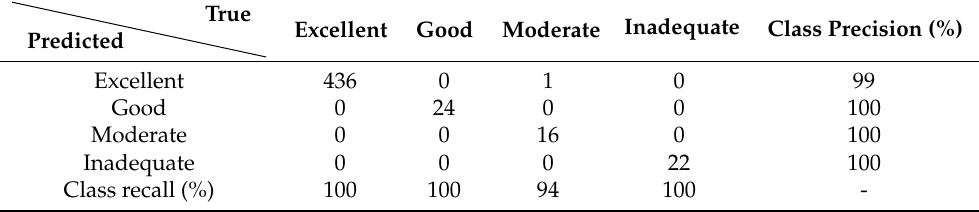
Table 6. Confusion matrix of the decision-tree algorithm applied to the flock-based variables dataset.